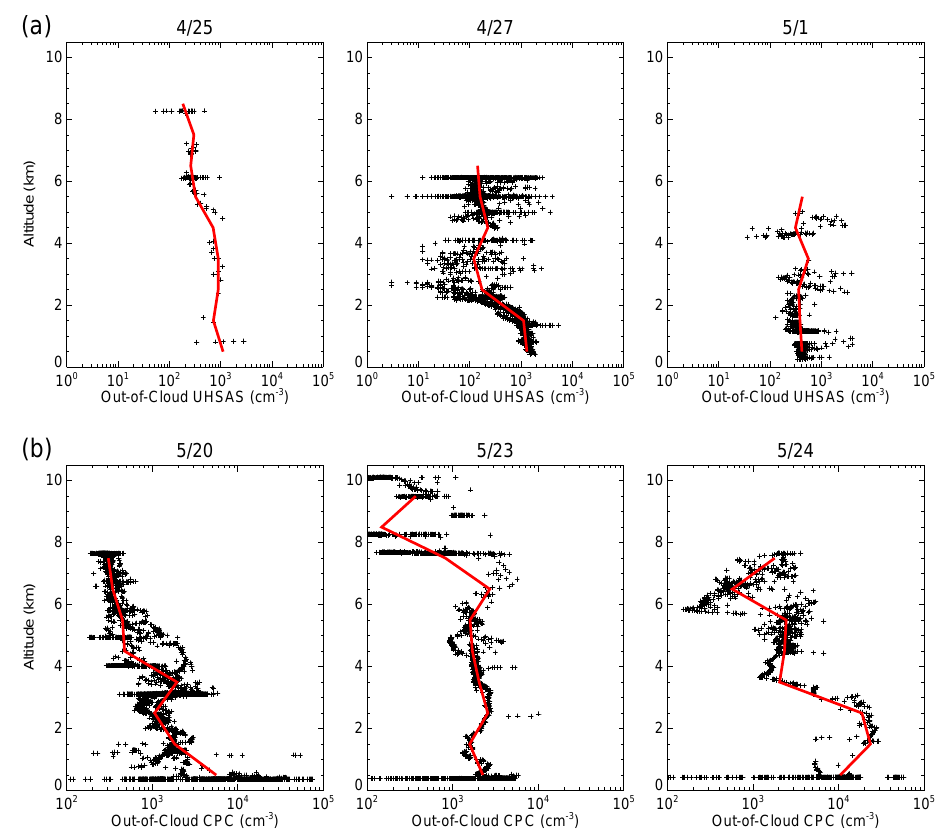
Figure 4. Out-of-cloud measurements of aerosol number concentration available on case study days (black symbols) from UHSAS (a) and airborne CPC (b) and median values over 1km deep layers (red lines). Dates are indicated in m/dd